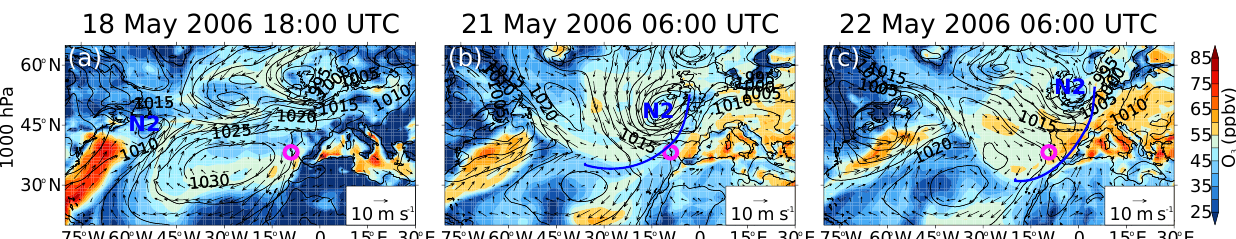
Figure 12. Synoptic conditions and O 3 distribution for the N2 cyclone at 1000hPa: MACC O 3 (color) and horizontal wind vectors (10ms − 1 reference arrow) and MSLP (solid contours, 5hPa intervals) on (a) 18 May 2006 at 18:00UTC, (b) 21 May 2006 at 06:00UTC, and (c) 22 May 2006 at 06:00UTC. The approximate cold front ( b , c ; blue line) and Monte Velho (pink open circle) are